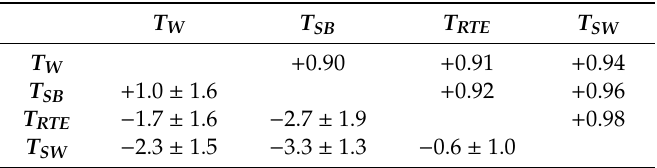
Table 3. Relation among contemporary water bodies temperatures T W obtained on various dates by di ff erent methods. The upper triangle shows correlation coe ffi cients among pairs. The lower triangle shows di ff erences (column-row, ◦ C). T W T SB T RTE T